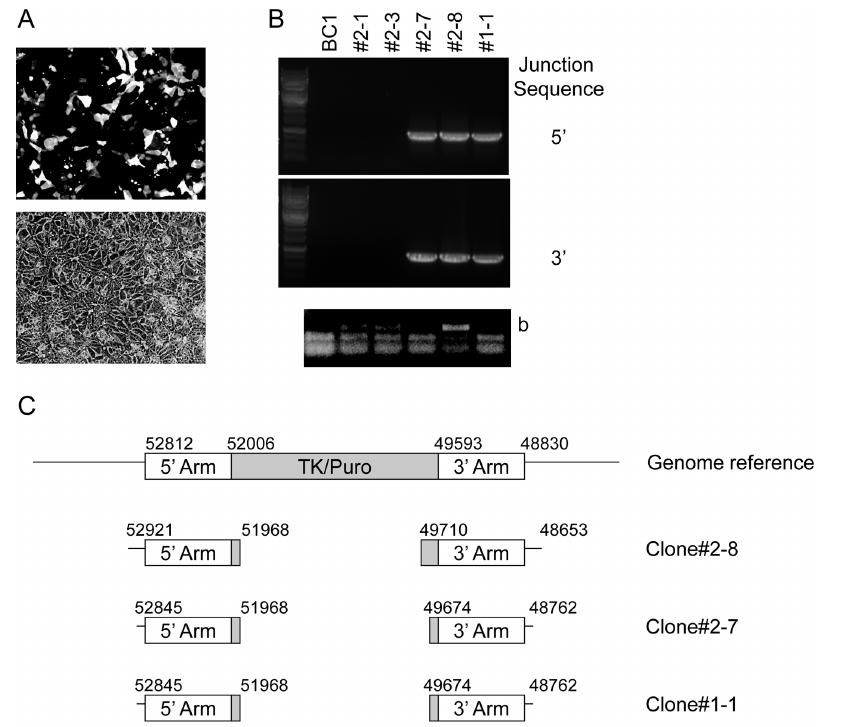
Figure 5. Analysis BC1 iPSC clones. A. Nucleofection of BC1 iPSC using the pmaxGFP plasmid. Top panel: Fluorescence image of transfected cells shown in grayscale; Bottom panel: Bright field image. B. Nested PCR amplification of genomic insertion sites (top and middle panels) and donor plasmid backbone sequence (bottom panel) using primers shown in Fig. 4A. Primers p9/p6 and p10/p5 were used to amplify the 5 9 junction sequence and primers p7/p12 and p8/p11 for the 3 9 junction sequence. Each clone was passaged at least 6 times before genomic DNA was isolated. C. Analysis of insertion junction sequences for clones # 2-8, 2-7 and 1-1. The numbers above the diagrams reflect arbitrary numbers. The 5 9 and 3 9 homology arms extending from nucleotides 52006 to 52812 and nucleotides 48830 to 49593, respectively are depicted as open boxes. TK/Puro sequences are highlighted in gray. The PCR products for clones # 2-8, 2-7, and 1-1 spanning the 5 9 or 3 9 arms plus flanking sequences were- subcloned and sequenced. The numbers indicate the regions that were confirmed by sequencing.